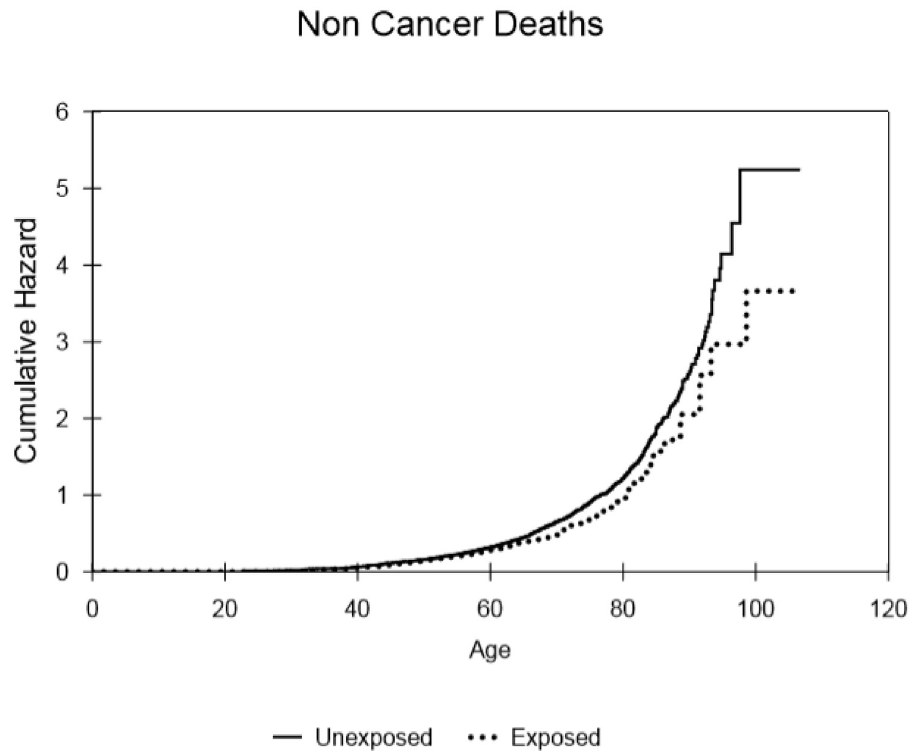
Fig 4. Cumulative hazard for death from non-cancer causes, within the selected populations of males that either received or did not receive the typical dose of 224 Ra, as a function of attained age.